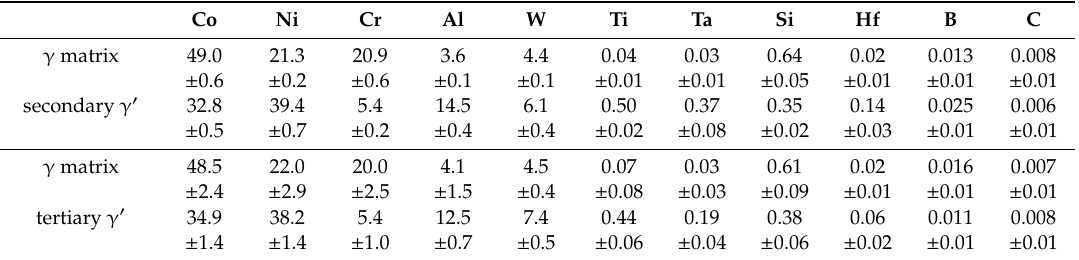
Table 2. Composition (at.%) of the secondary and tertiary γ (cid:48) precipitates and the surrounding γ matrix phase of CoWAlloy2 determined by atom probe tomography (APT) [10].